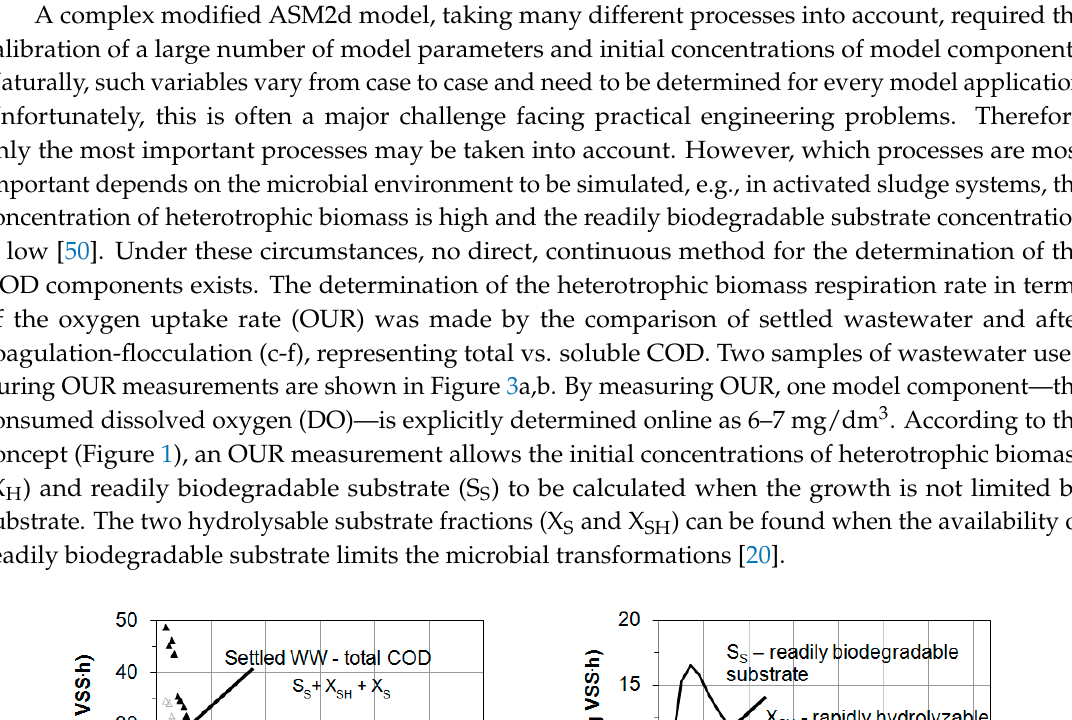
( b ) Figure 4. Exemplary results of the respirometry test and COD measurements during the summer study period, T = 20 °C from Gda ń sk WWTP: ( a ) OUR behavior vs. model prediction with the settled wastewater and biomass ( b ) total vs. soluble COD with the settled wastewater and after coagulation- flocculation (c-f) Consequently, the importance of microbial processes differs in the Gda ń sk and Malaga WWTPs, leading to different types of systems and microbial transformations involved according to the climate and local special industries (e.g., vineyards in Malaga). However, for the purpose of characterizing